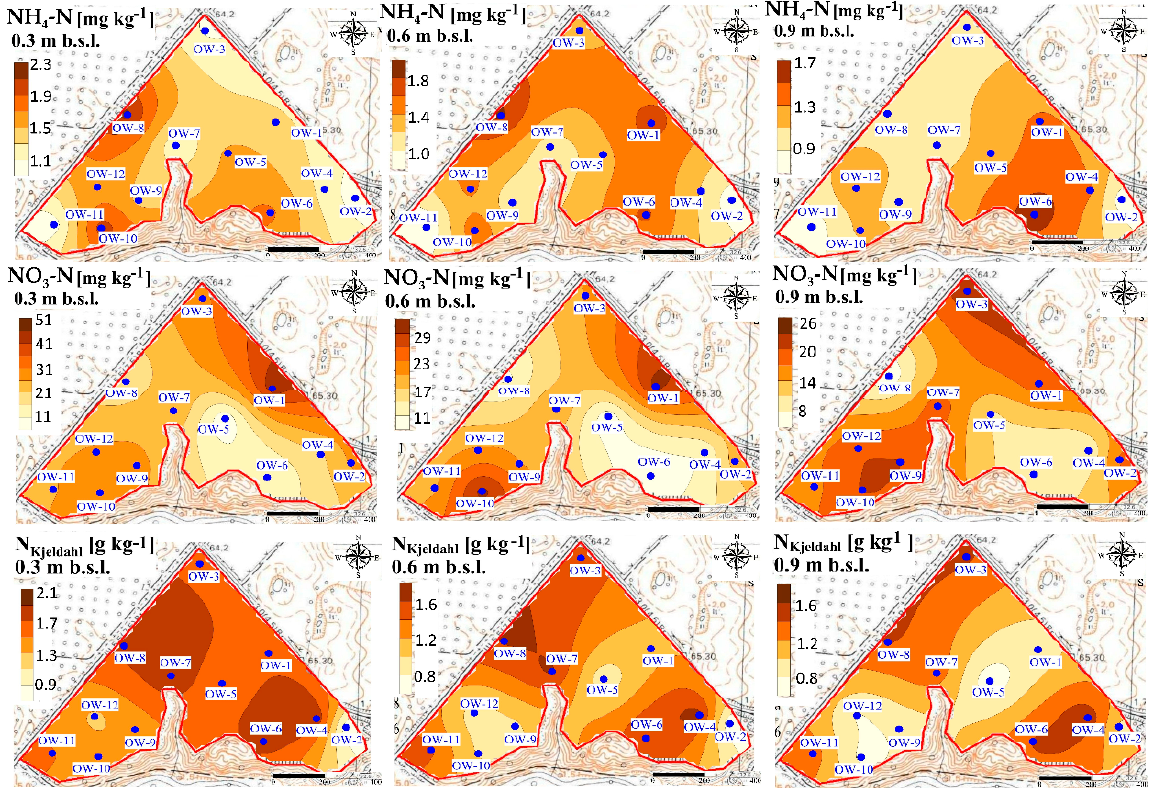
Figure 11. Spatial distribution of ammonium, nitrate, and N Kjeldahl in soil at the B experimental site after VRA fertilization.